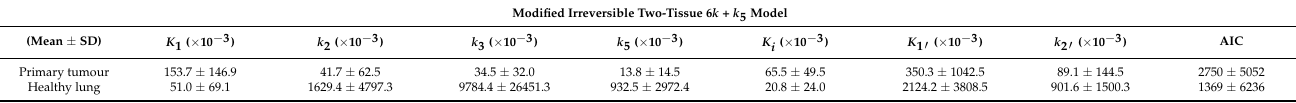
Table 4. Result of the compartmental